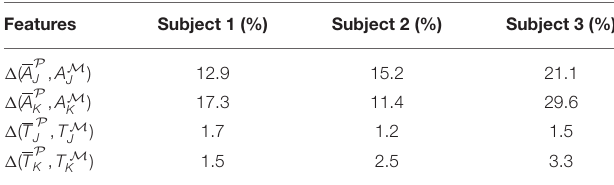
TABLE 6 | Quantitative comparison between the J-K features in the experimentally-measured ( M ) and EA-predicted ( P ) curves.